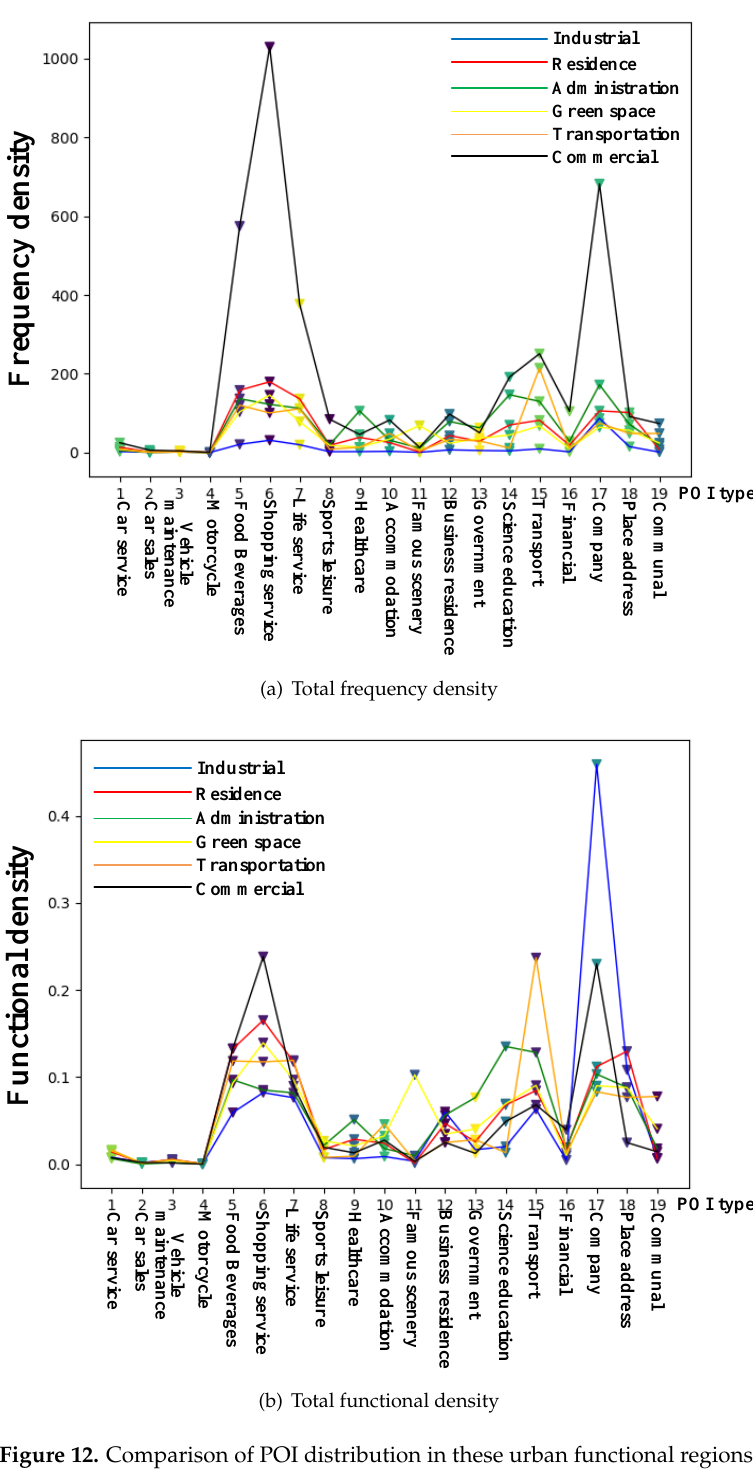
Figure 12. Comparison of POI distribution in these urban functional